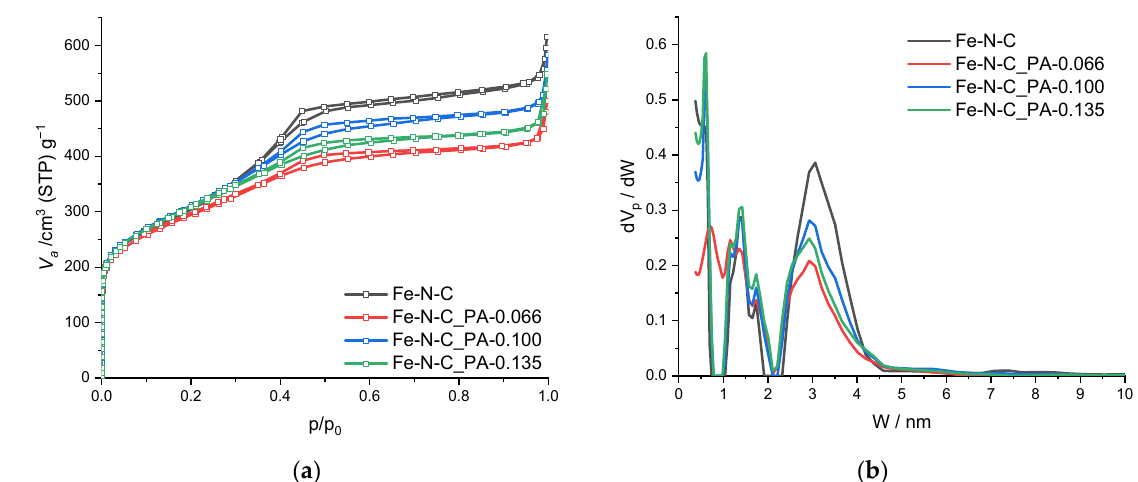
Figure 4. ( a ) N 2 isotherm and ( b ) pore size distribution of Fe-N-C catalysts. (V a : adsorbed volume; dV p : differential pore volume; dV p /dW: pore area distribution).